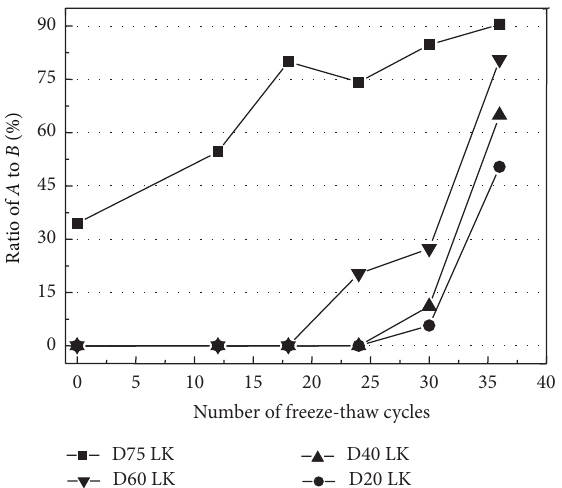
Figure 5: Ratio of 𝐴 to 𝐵 under the action of freeze-thaw cycles ( 𝐴 : volume of connected pores; 𝐵 : volume of all pores).